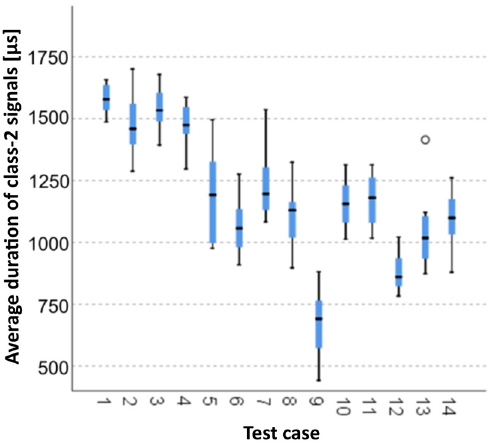
Figure 7. Graphic presentation of the Kruskal–Wallis test results for independent samples: average duration of class-2 signals.